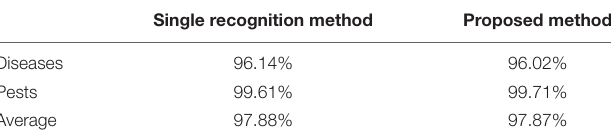
TABLE 3 | Performance comparison of single recognition method and proposed